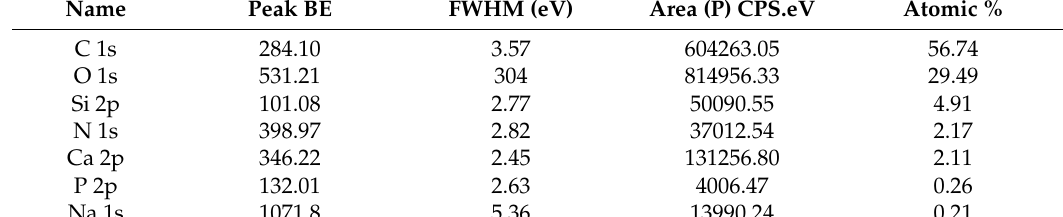
Table 1. Elemental distribution on BGN / PMMA / SS sample surface. Table 2. Roughness values of thin films before immersion in simulated body fluid (SBF).